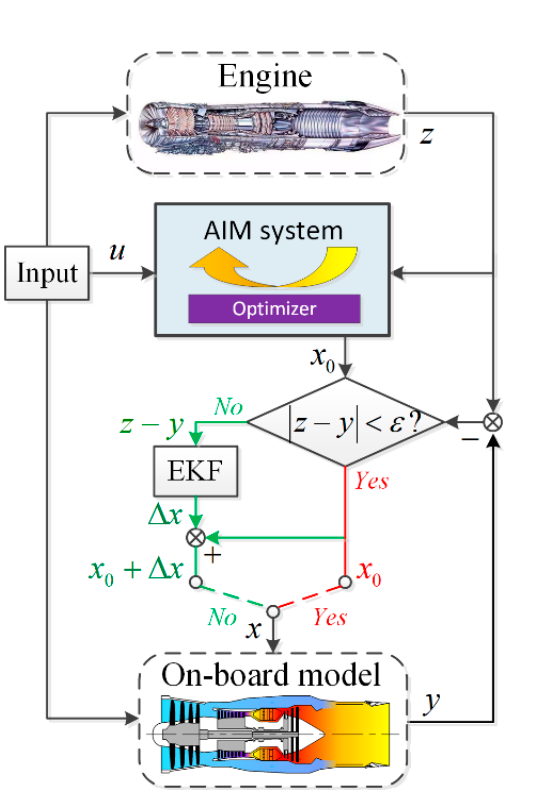
Figure 6. Completed process of performance diagnosis.